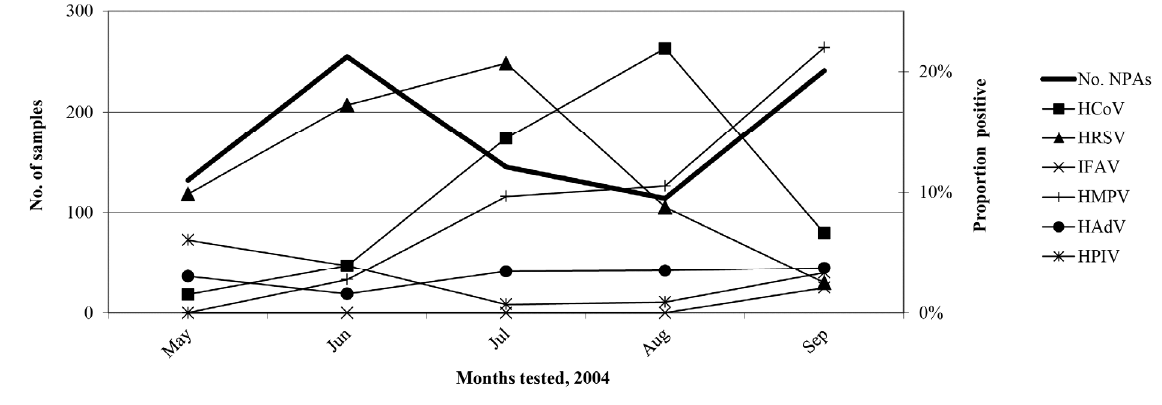
Figure 1. Specimens tested and the proportion of respiratory viruses positive during the study